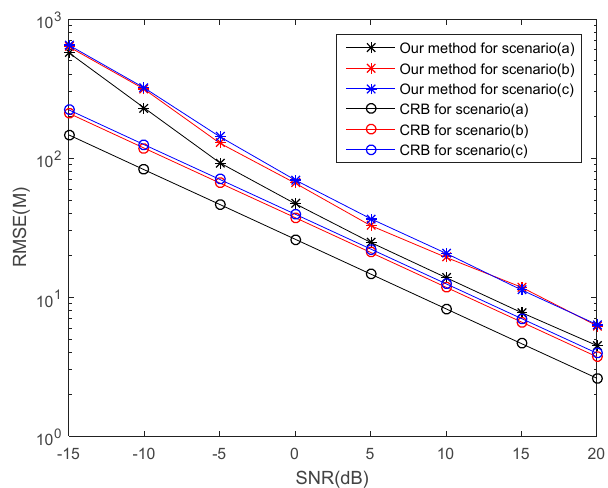
Figure 2. RMSEs versus SNR under different trajectories of receivers.